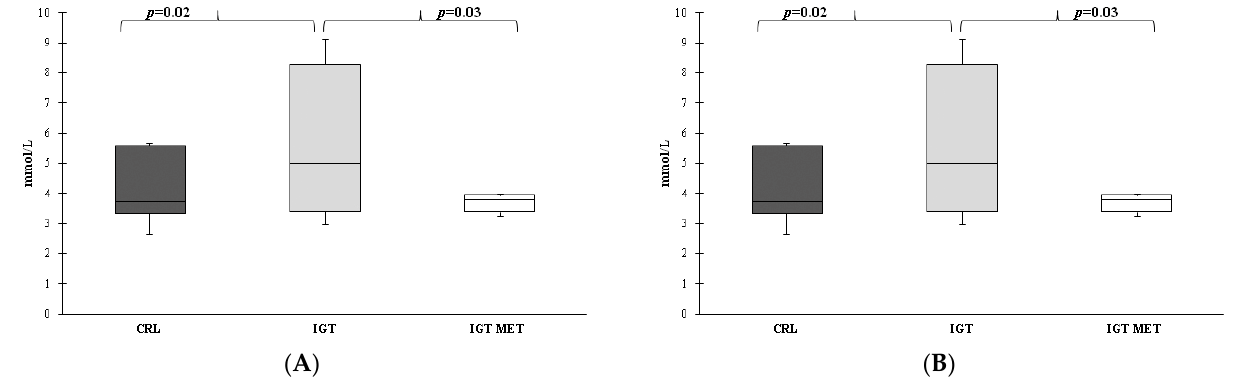
Figure 5. The lipid profile parameters of rats from different groups at the end of the experiment.